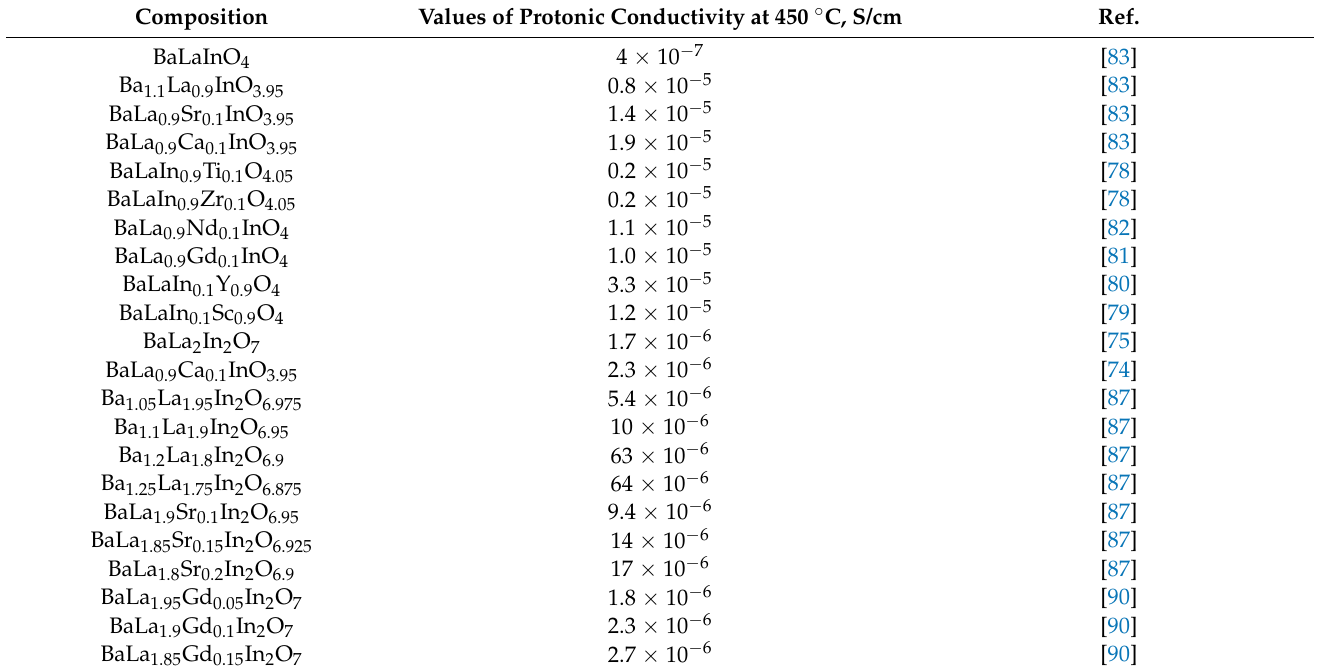
Table 1. The comparison of the protonic conductivity values of layered perovskites BaLn n In n O 3n+1 ( n = 1,